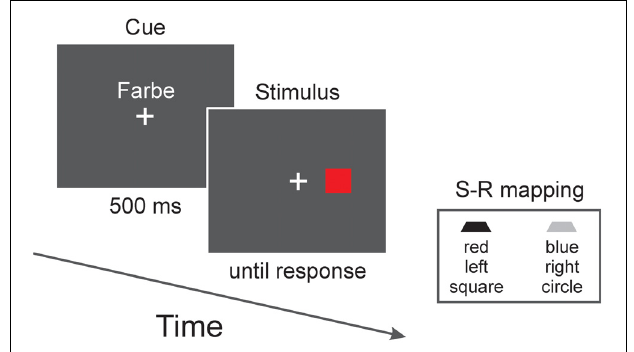
FIGURE 1 | Stimulus sequence of a trial. The cue presented in advance indicated the relevant stimulus dimension. In this example, color is relevant (as indicated by the German word “Farbe” which means color) and, according to the stimulus–response (S–R) mapping (shown is one out of eight possible mappings), the correct response is a left-button press. Note that for the location task, only compatible S–R mappings were used in Experiments 1 and 2 and only incompatible mappings were used in Experiment 3. Furthermore, for Experiments 2 and 3 the color task was replaced by a pattern task (i.e., objects were filled with either horizontal or vertical black/white